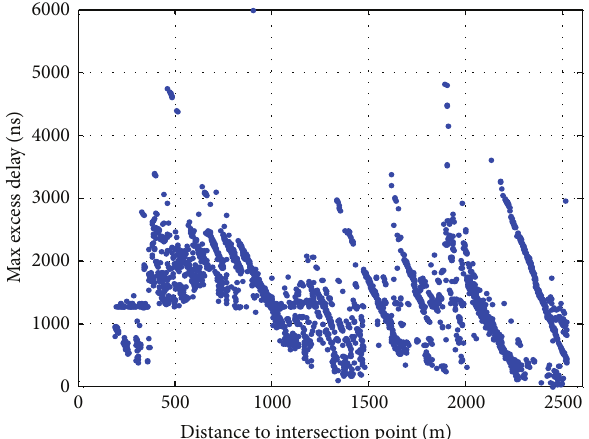
Figure 5: Maximum excess delay in HSR hilly terrain.